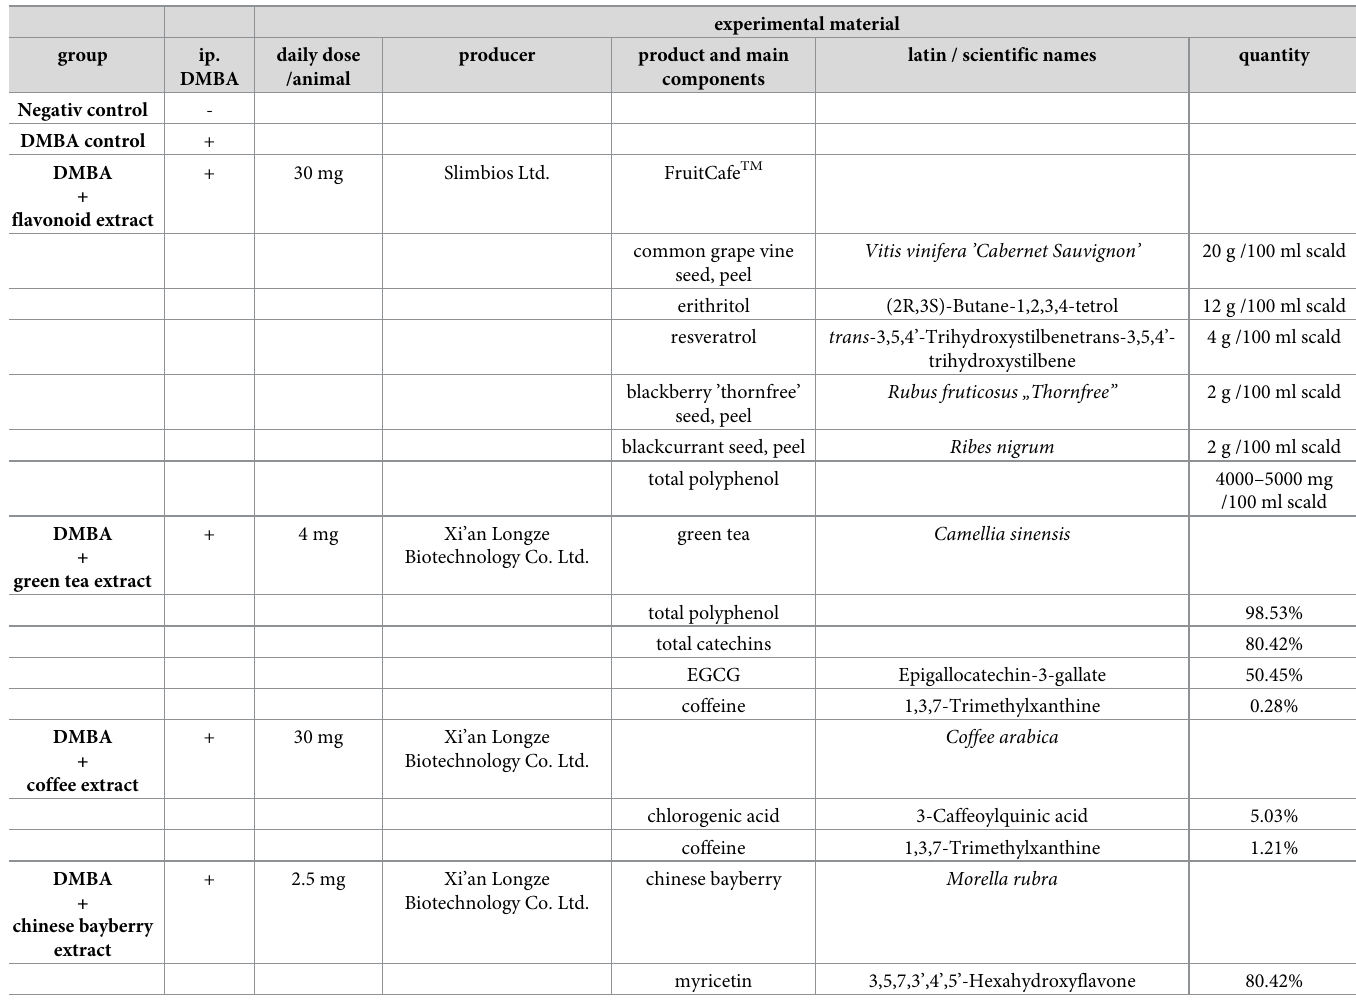
Table 1. Arrangement of experimental groups and treatments.